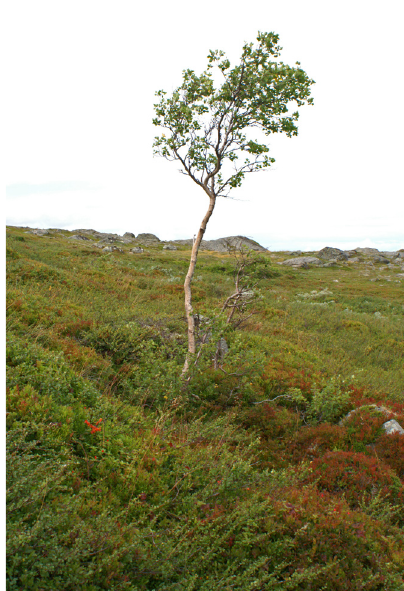
Figure 10: Young birch tree growing in a minor depression with more ample snow and moisture conditions than in the surrounding wind-exposed heath. Mt. Tjalmetjallentj- akke, 890 m a.s.l. 29 August,